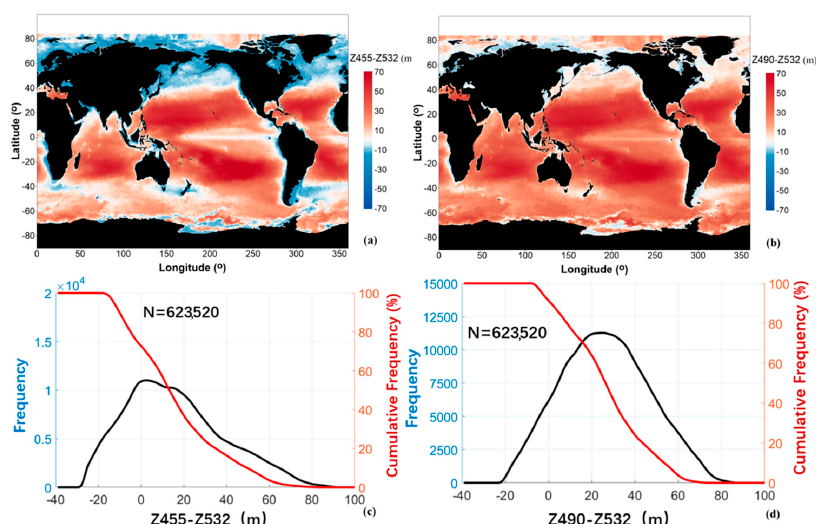
Figure 6. Global distribution of the maximum detection depth di ff erence ( a , b ) and the frequency and cumulative frequency distributions of the di ff erences ( c , d ) following the assumption that the optimal detection for lidar is 4 AL between 455 and 532 nm ( a , c ) and 490 and 532 nm ( b , d ), respectively.